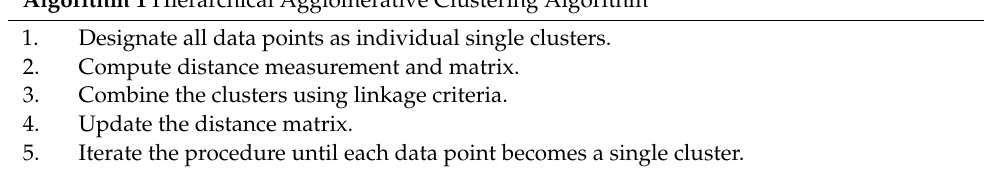
Algorithm 1 Hierarchical Agglomerative Clustering